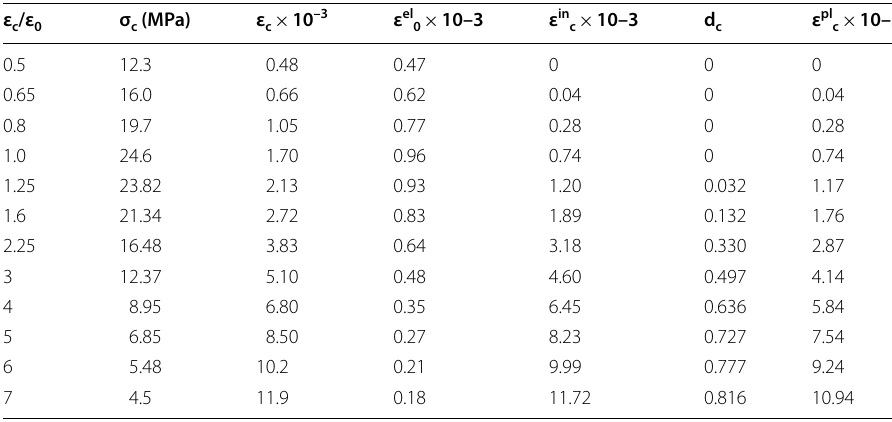
Table 3 Values of compressive parameters for concrete ε c /ε